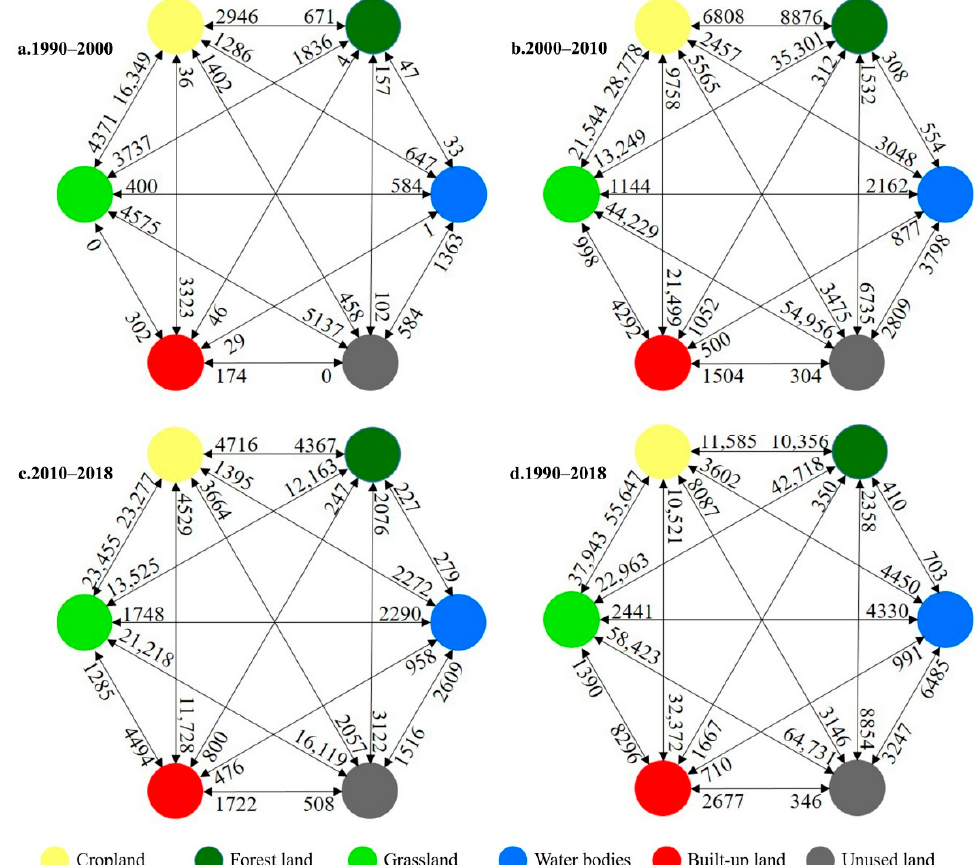
Figure 3. Land use transfer matrix in the YRB during 1990–2018 (km 2 ).